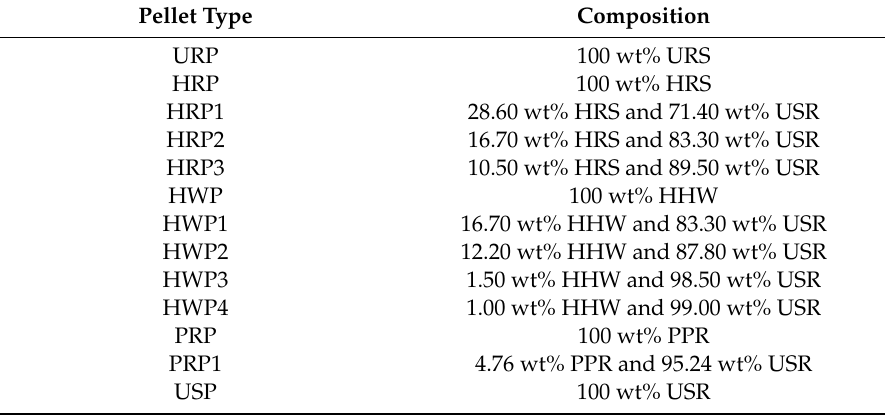
Table 2. Composition of different pellets.